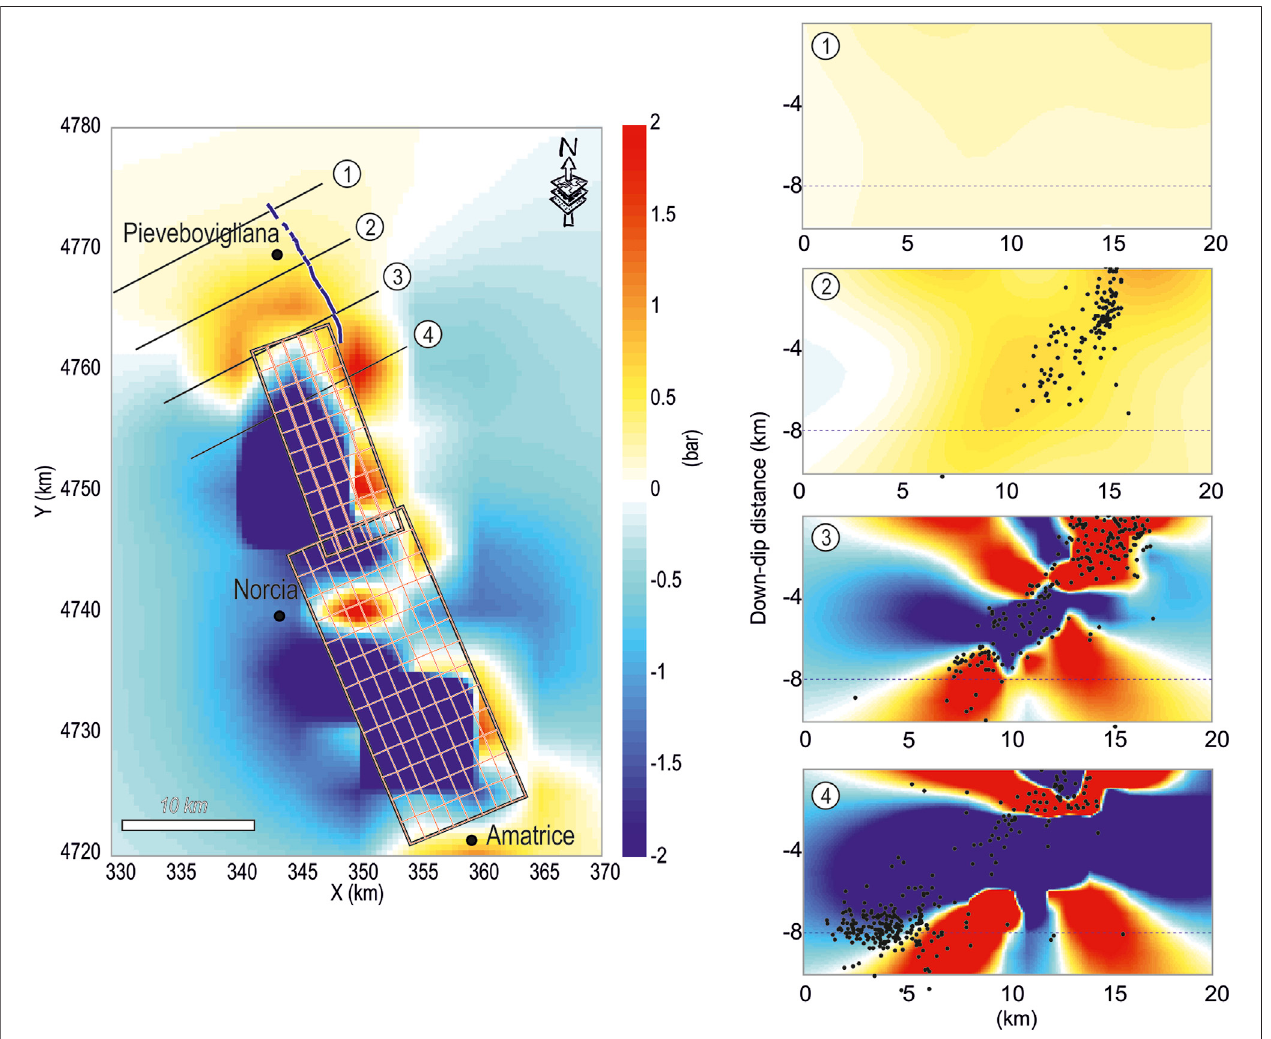
FIGURE 10 | Map and cross-sections of Coulomb stress changes (see color bar), induced by EQ1 and EQ2, on a generic plane compatible with the main fault alignment, computed with heterogeneous slip models (Chiaraluce et al., 2017) at a depth of 8 km and along the geological cross-sections. On the map, the black rectangles representthe modeled fault planes and thered ones thesub-faults. The numbers 1 – 4 refer togeological cross-sections. The blue lineon the map represents the fault trace of the reconstructed Pievebovigliana fault. The black dots along the cross-sections are the locations of aftershocks computed by Chiaraluce et al. (2017) occurring from 2016/08/24 to 2016/10/30 and projected on the cross-sections considering a half-width of 2.5 km.